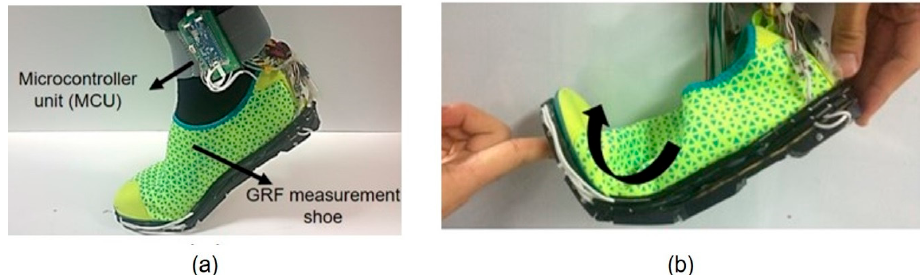
Figure 2. Bendable outsole biaxial ground reaction force measurement system. ( a ) Developed system connected to the microcontroller with a Bluetooth module. ( b ) Developed system with a bendable design.